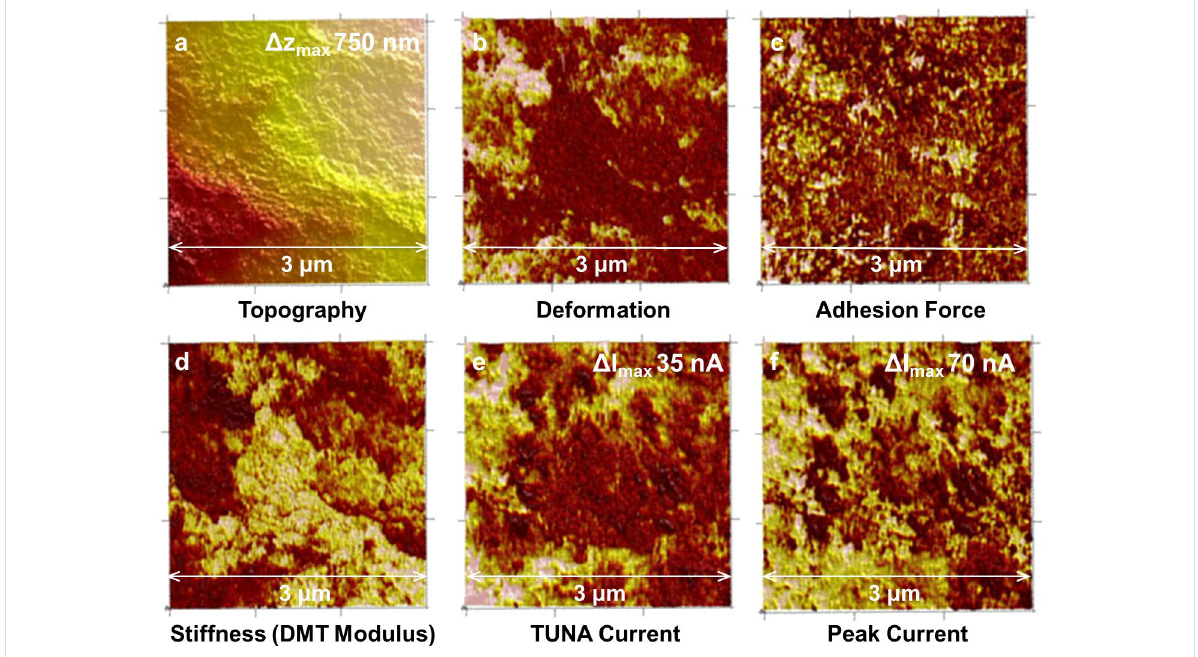
Figure 6: AFM images of an SC-PVDF sample before cycling. a) topography, b) deformation, c) adhesion, d) DMT modulus (stiffness), e) PeakForce- TUNA ™ current, f) PeakForce QNM ™ current (brighter colours are higher values).